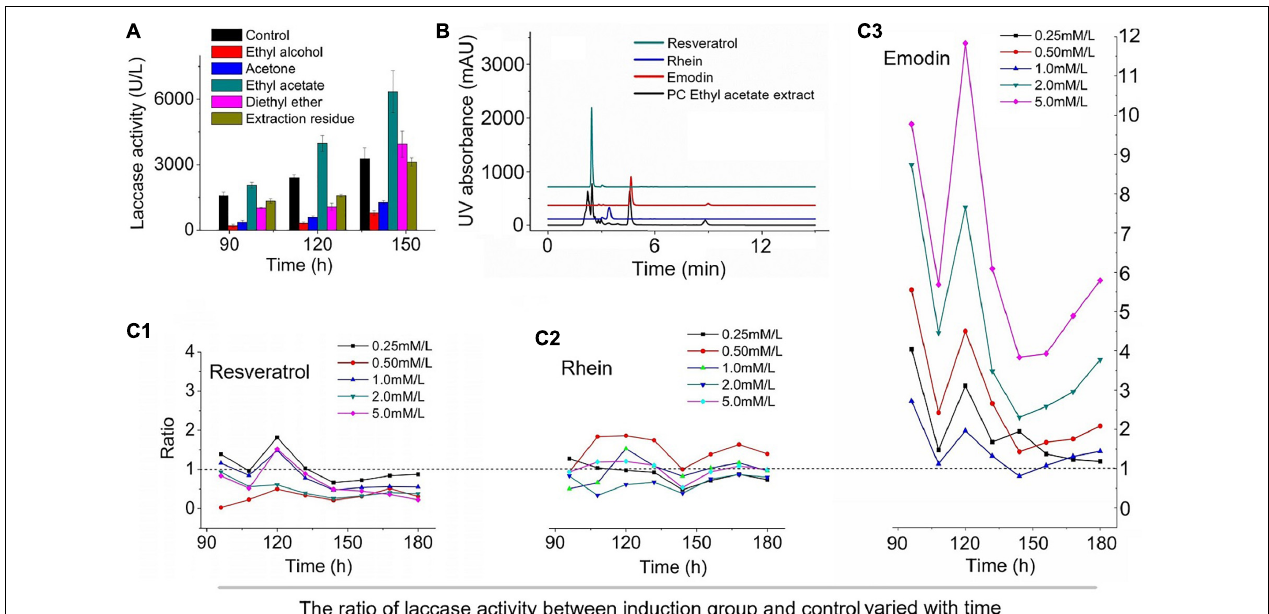
FIGURE 1 | The effect of different components of Polygonum cuspidatum on the laccase production of Trametes versicolor. (A) , The effect of extracts of different polar solvents on the activity of laccase; (B) , HPLC analysis of ethyl acetate extract; and the effects of different concentrations of resveratrol (C1) , rhein (C2) , and emodin (C3) on laccase production in T. versicolor, The value is the ratio of laccase activity to the control group under the influence of three inducers at different